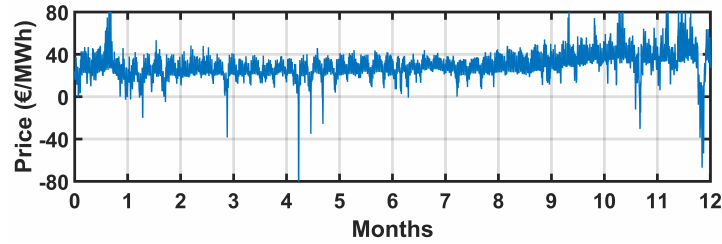
Figure 12. Grid energy price signal.